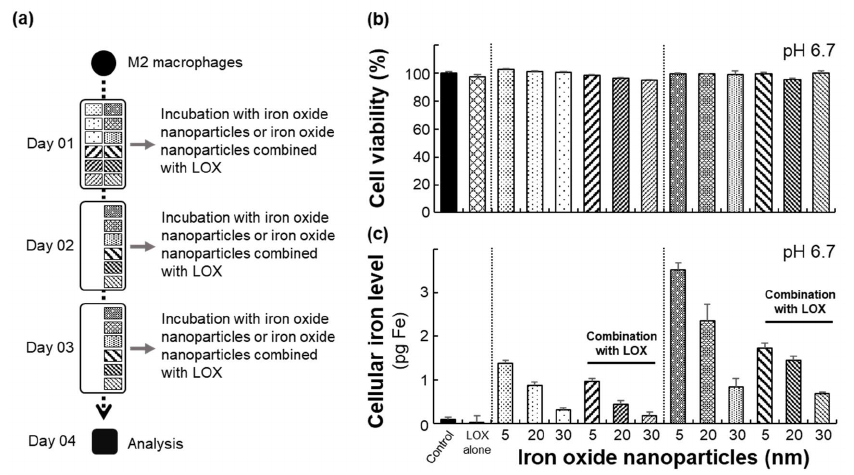
Figure 3. Characterization of materials: ( a ) Treatment protocol for M2 macrophages under various conditions. ( b ) Cell viability of macrophages after incubation with various treatments. Cell viability is given as the percentage of viable cells remaining after treatment for 72 h compared with that of the unexposed cells determined by the MTS assay. The bars represent the mean ± standard deviation ( n = 4). ( c ) Qualitative determination of iron oxide nanoparticles in treated macrophages incubated in various conditions. The bars represent the mean ± standard deviation ( n = 4).